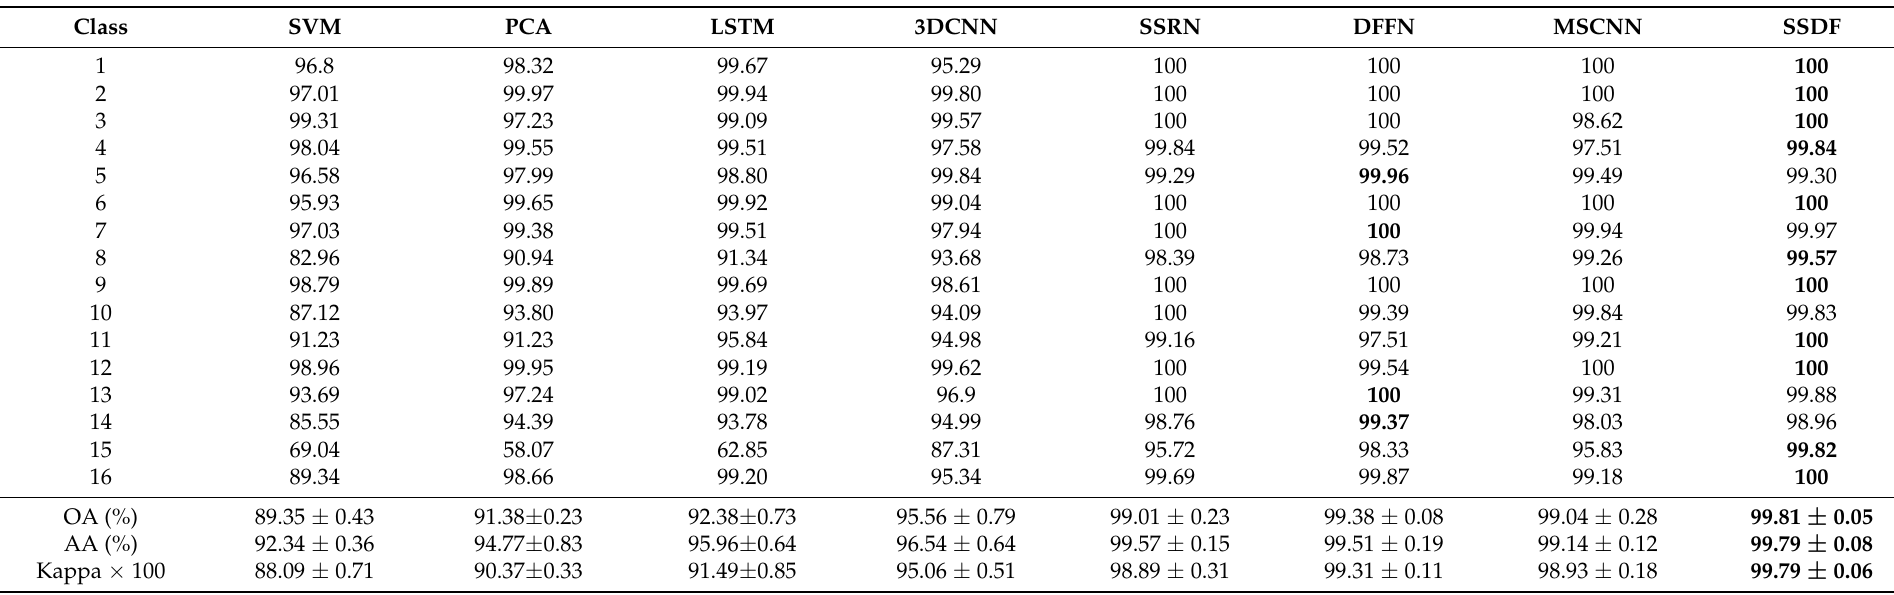
Table 6. The classification results of all methods on the Salinas scene dataset with OA, AA, and Kappa data given in the form of mean ± standard